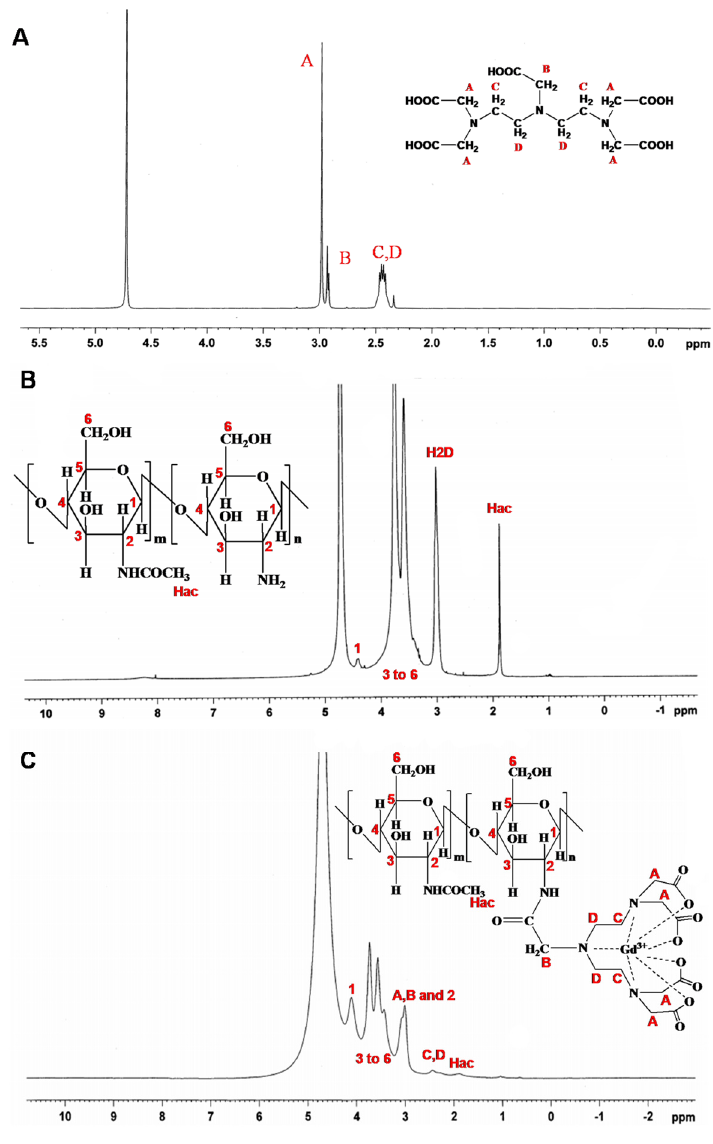
Figure 2. 1 HNMR spectra of DTPA ( A ); CS ( B ) and CS-DTPA-Gd( C ).